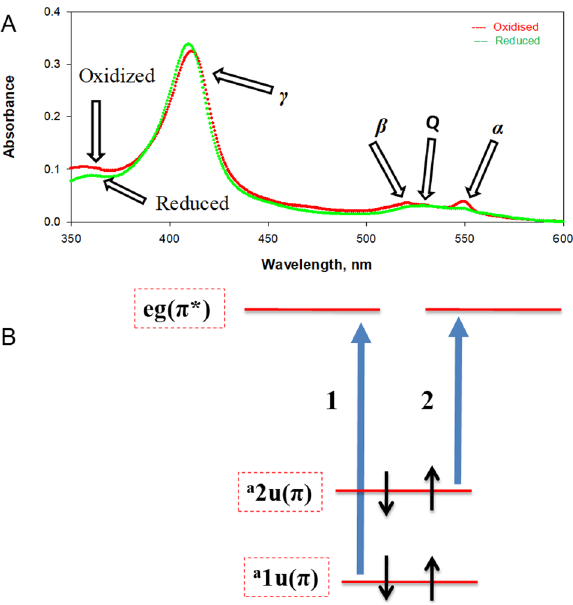
Figure 3. UV–Vis absorption spectra of the oxidized and reduced WT cyt c in the native buffer (30 mM cacodylate containing 100 mM NaCl (pH 6.0) at 25 ± 0.1 °C. (A) UV–Vis absorption spectra of the oxidized (red curve) and reduced (green curve) cyt c . (B) Molecular orbital diagram for the four-orbital model describing metalloporphyrin absorbances. The figure was redrawn from the ref. 34 .